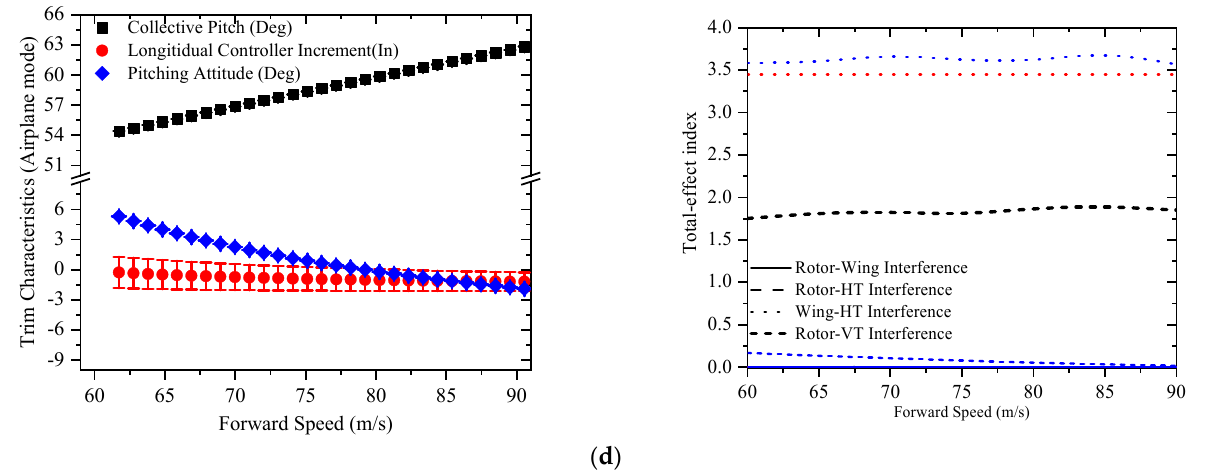
Figure 4. Trim sensitivity results. ( a ) Helicopter mode; ( b ) Conversion mode (30 Deg); ( c ) Conversion mode (60 Deg); ( d ) Airplane mode.